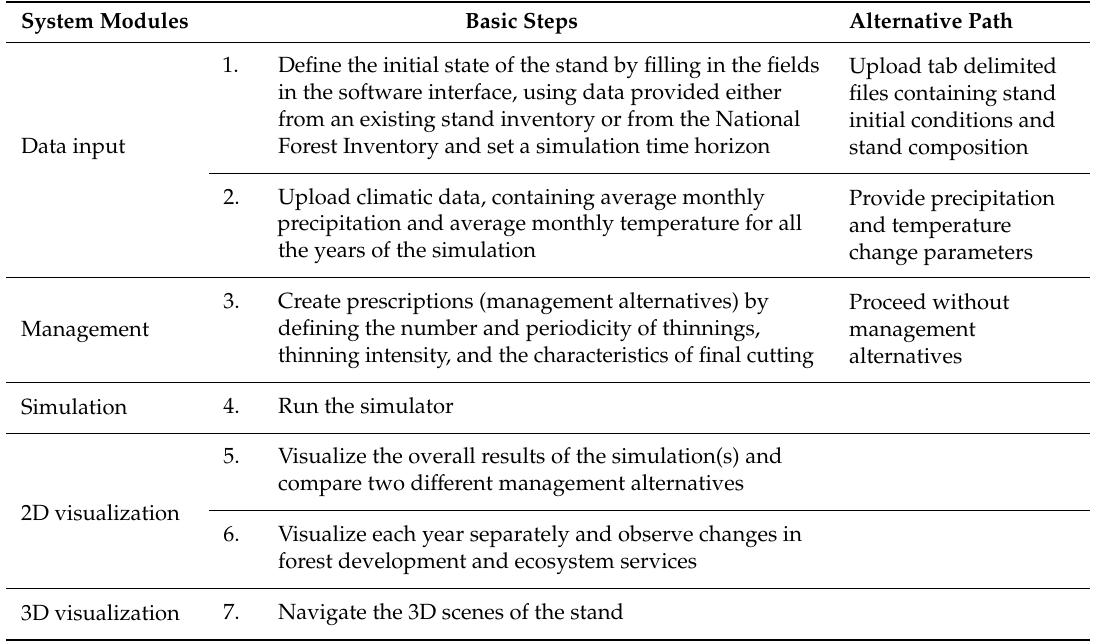
Table 2. Use case scenario